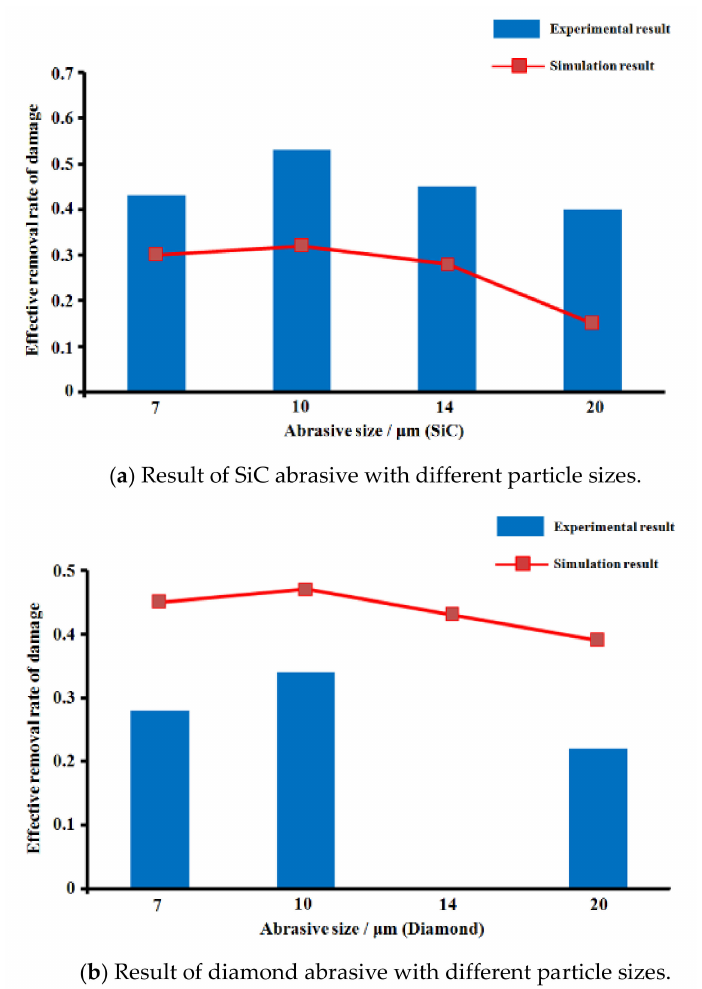
Figure 7. Results of ERRD with di ff erent